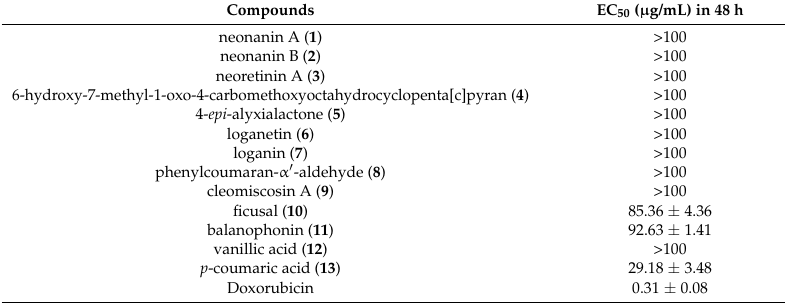
Table 2. Effects of compounds isolated from Neonauclea reticulate and the cytotoxicity viability of Hep3B cell.